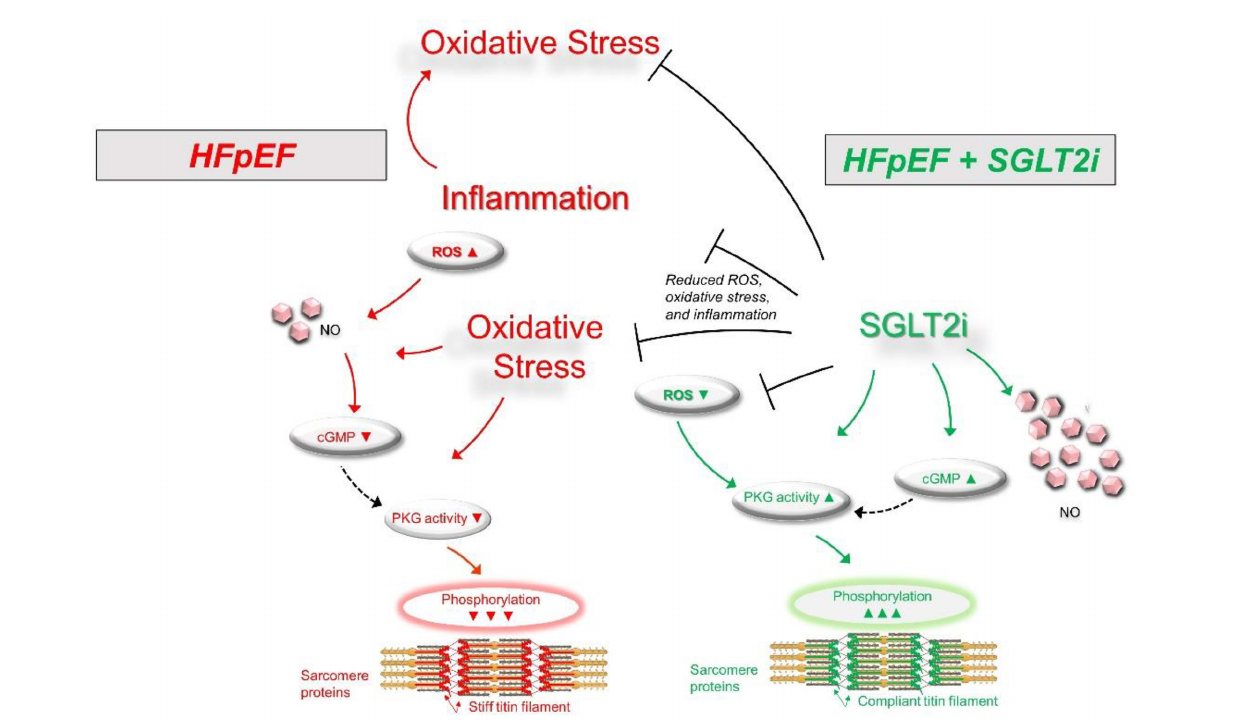
FIGURE 2 | Scheme for the signaling pathways in HFpEF (left) showing an oxidative condition with impaired signaling pathways via increased inflammation and oxidative stress (Upward arrows = increase; downward arrows = decrease). SGLT2i treatment (right) may result in a significant improvement of signaling pathways via decreased inflammation and oxidative stress. cGMP, cyclic guanosine monophosphate; HFpEF, heart failure with preserved ejection fraction; NO, nitric oxide; PKG, protein kinase G; ROS, reactive oxygen